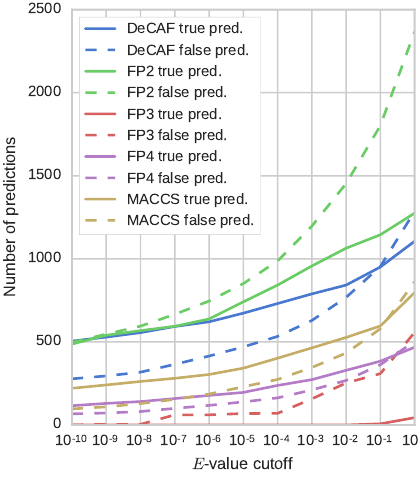
Figure 4. Reliability of the predictors. The plot shows the number of true (solid line) and false (dashed line) predictions with E -values below the specified